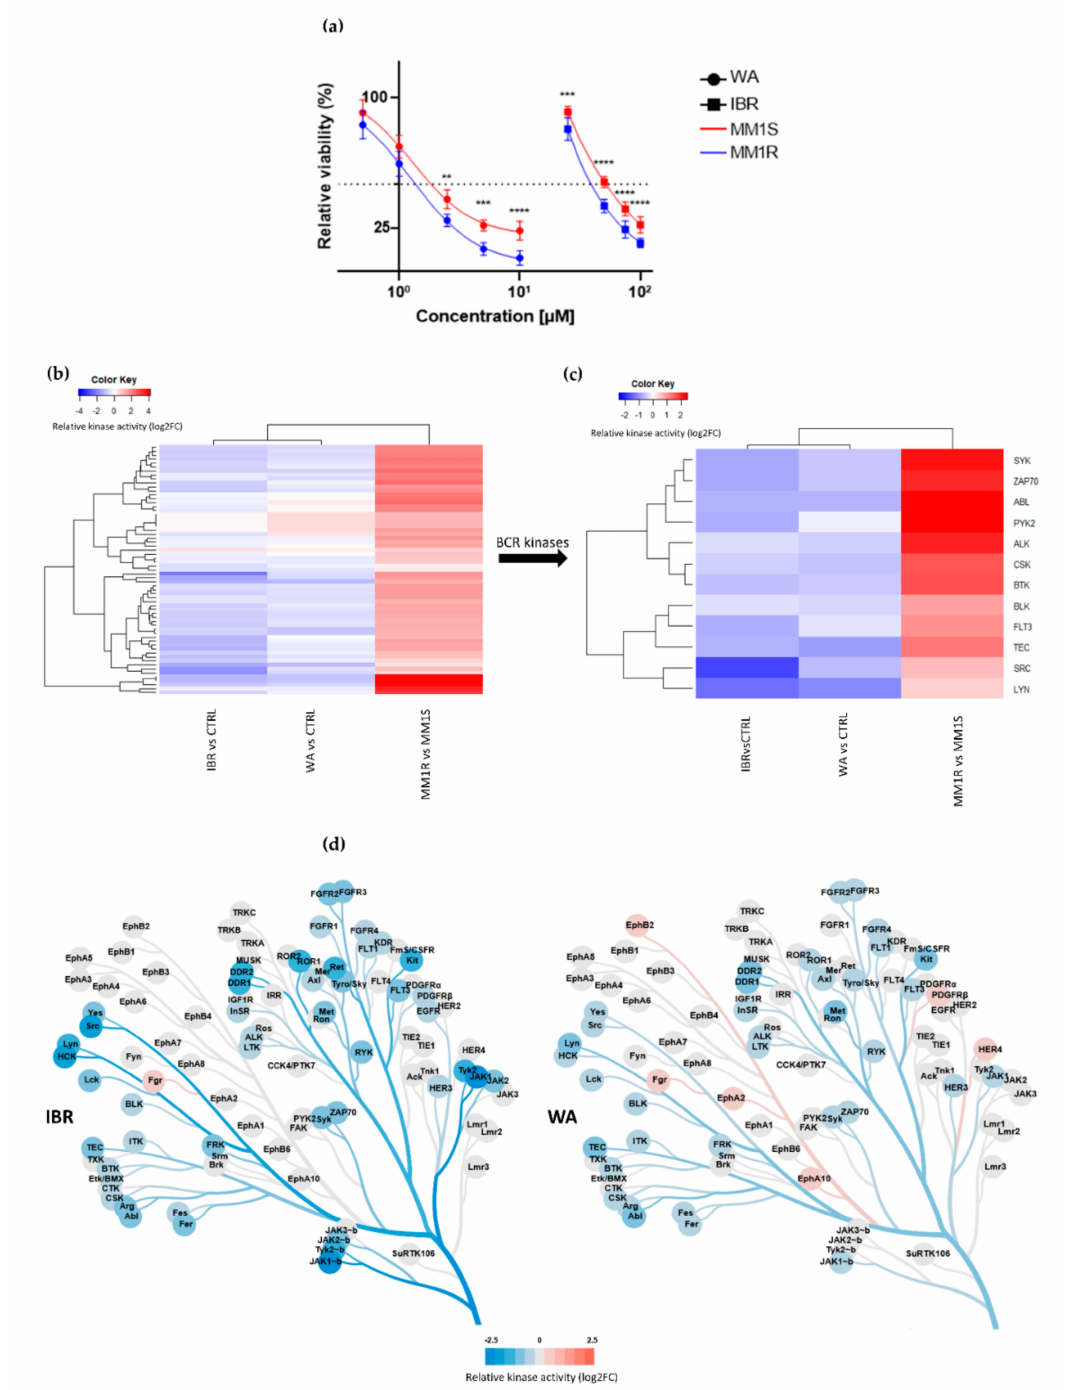
Figure 2. ( a ) Relative cell viability of MM1 cells upon 24 h exposure to increasing concentrations of BTK inhibitor ibrutinib (IBR) or withaferin A (WA). Data are plotted as the mean ± s.d., n = 3 biologically independent replicates. (** p < 0.01, *** p < 0.001 **** p < 0.0001, ANOVA). ( b ) Heatmap representation of hyperactivated or inhibited kinases in MM1R versus MM1S cells, or following 15 min IBR or WA treatment, n = 3 biologically independent replicates per treatment group. ( c ) Close-up heatmap representation of Figure 2b showing inhibited BCR-related kinases in MM1R versus MM1S or following 15 min IBR or WA treatment, n = 3 biologically independent replicates per treatment group. ( d ) Kinase trees displaying the tyrosine kinase targets of IBR (left) and WA (right). Kinase trees were generated with the CORAL web tool (http://phanstiel-lab.med.unc.edu/CORAL/, accessed on 30 November